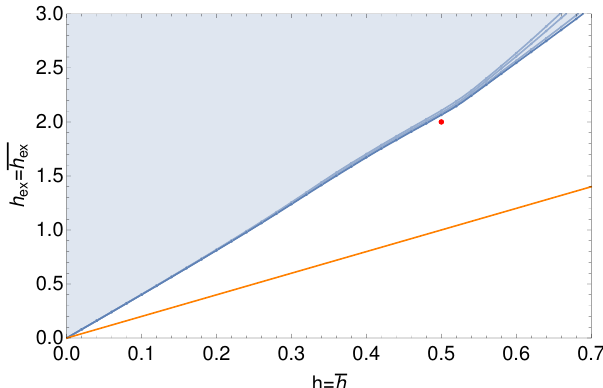
Figure 4 . Upper bound on the dimension of the (cid:12)rst uncharged scalar long superconformal primary that appears in the OPE, as a function of the dimension of the external operator h = (cid:22) h for (cid:3) = 16 ; 18 ; : : : ; 22 derivatives. The red dot marks the dimension of the known (2 ; 2) and (2 ; 0) minimal models discussed below eq. (3.3) . The orange line corresponds to the generalized free (cid:12)eld theory solution h ex = 2 h